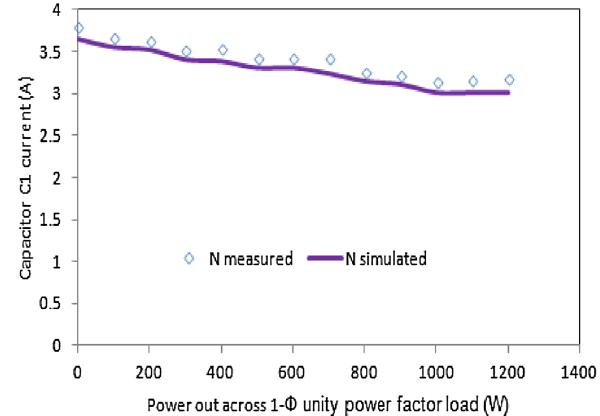
Fig. 15 Variation pattern of capacitor current with power